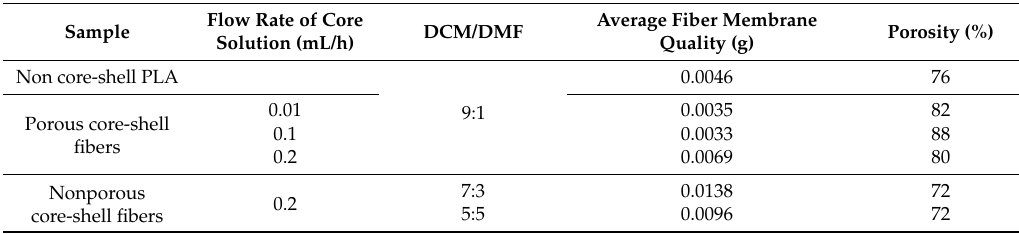
Table 3. Porosities of PLA and core-shell